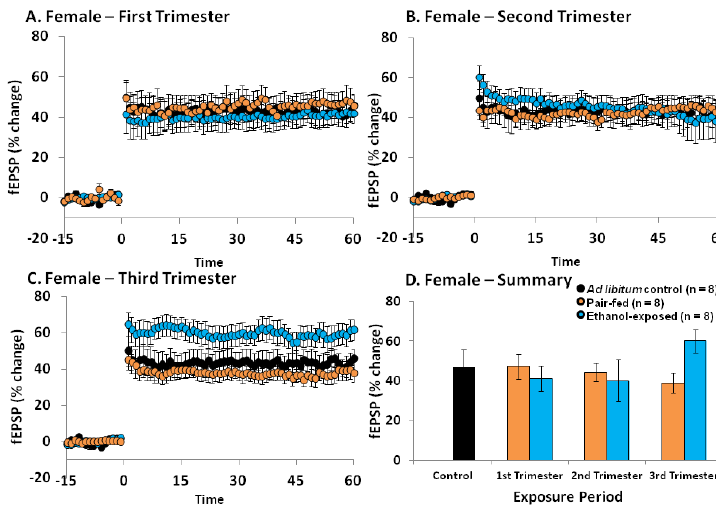
Figure 2. The effects of PNEE during specific trimester equivalents on LTP in the DG of young adult female rats. PNEE during either the 1st ( A ) or 2nd ( B ) trimester equivalents does not result in a significant reduction in DG LTP. ( C ) PNEE during the 3rd trimester equivalent significantly increased LTP in females when compared to their respective ad libitum ( p < 0.01) and pair-fed ( p < 0.01) controls (see text for additional details on the statistical analysis). ( D ) Summary of LTP results calculated by assessing the initial phase of the EPSP slope (10%–80%) at 55–60 min post-TBS. Results are presented as means ± SEM and were considered statistically significant when p <